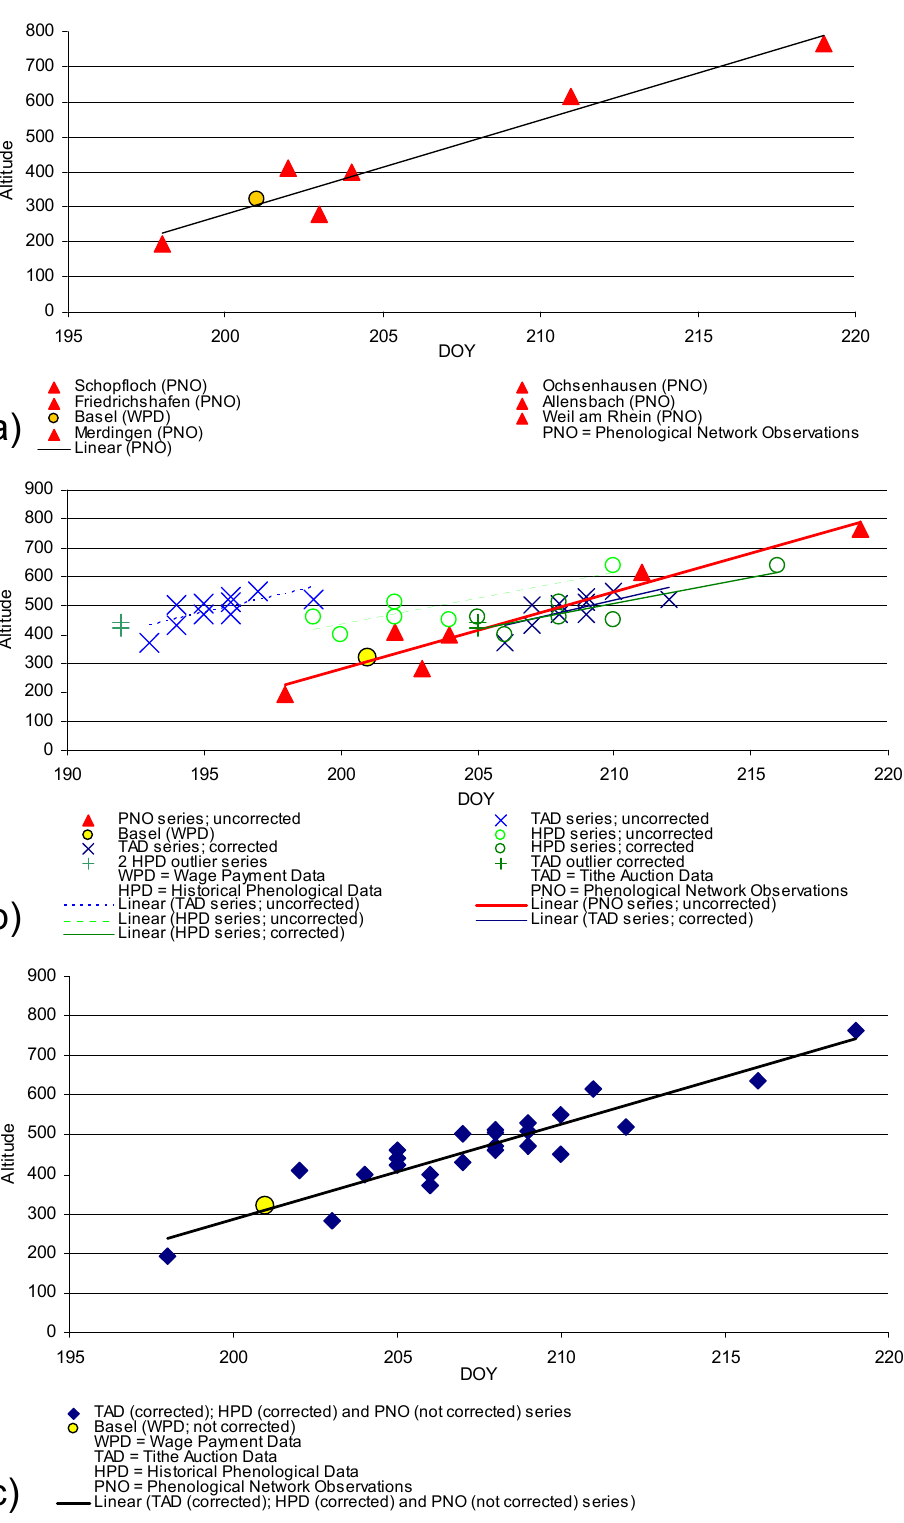
Fig. 5. (a) Basel WPD series and PNO series lying on the same altitude depending linear trend. (b) Statistical correction of HPD- and TAD series to the reliable PNO/WPD series. (c) Statistical correction of HPD- and TAD series to the reliable PNO/WPD series.